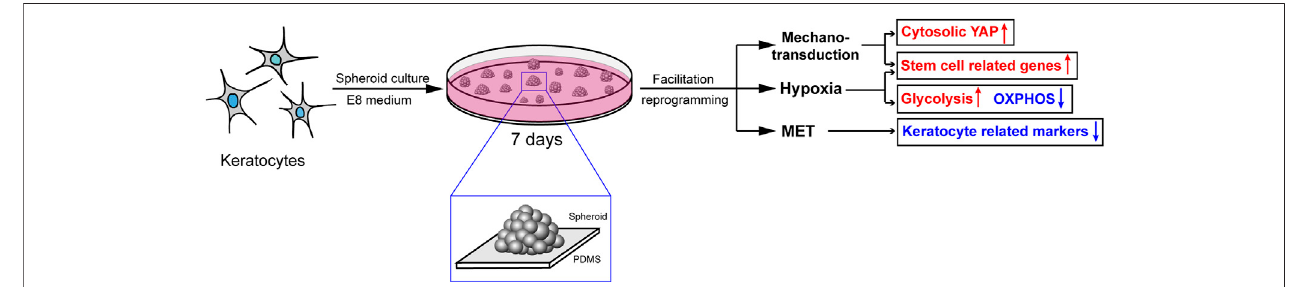
FIGURE 8 | The probable mechanisms of the effect of PDMS on facilitating reprogramming. Mechanotransduction, MET and hypoxia induced by PDMS might be responsible for the promotion of keratocyte reprogramming.